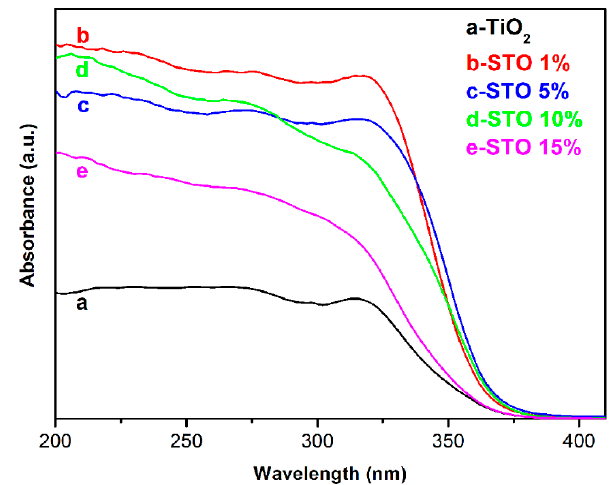
Figure 10. UV-vis absorption spectra of TiO 2 hierarchical nanospheres (24 h) (curve a) and STO hierarchical nanospheres with di ff erent molar ratios of n Sn / n Ti : 1% (curve b), 5% (curve c), 10% (curve d), and 15% (curve